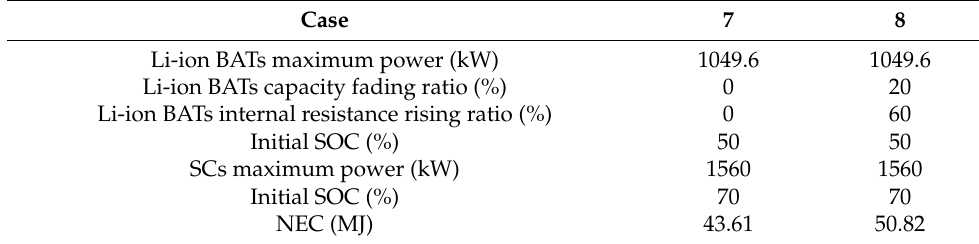
Table 7. The parameters and optimization results for cases 7–8.